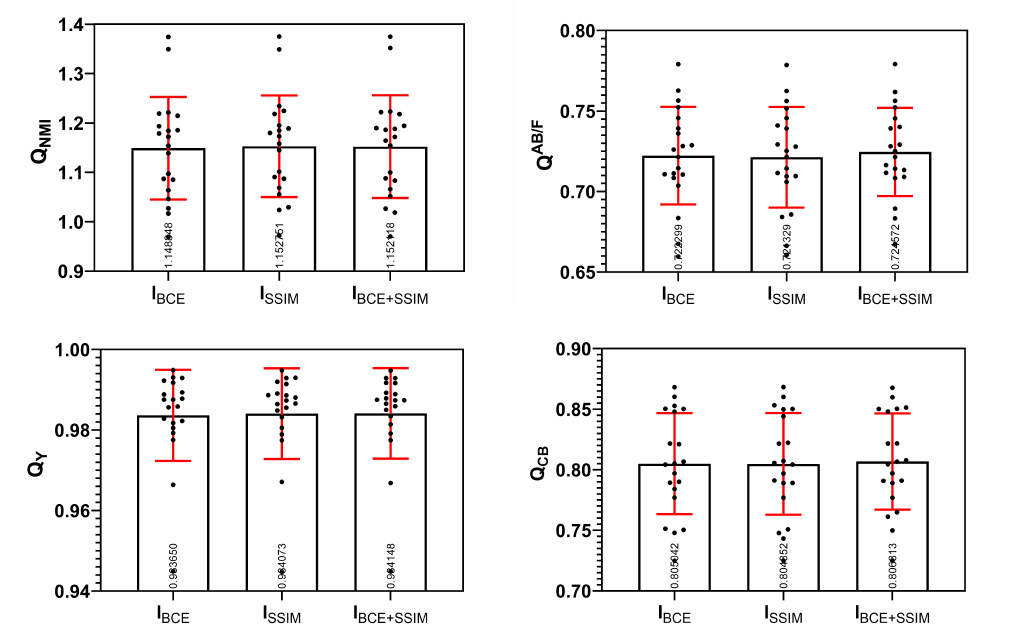
Figure A3. The quantitative results of different loss functions in the test data (20 pairs of